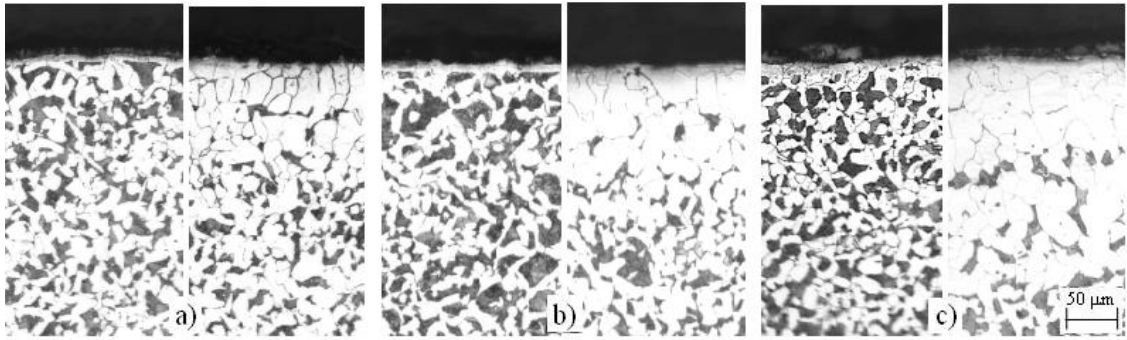
Figure 8. Microstructure of the surface part of C45 steel after annealing at T a = 950 °C. ( a ) t a = ½ h, ( b ) t a = 1 h, ( c ) t a = 2 h. ( b ) t a = 1 h, ( c ) t a = 2